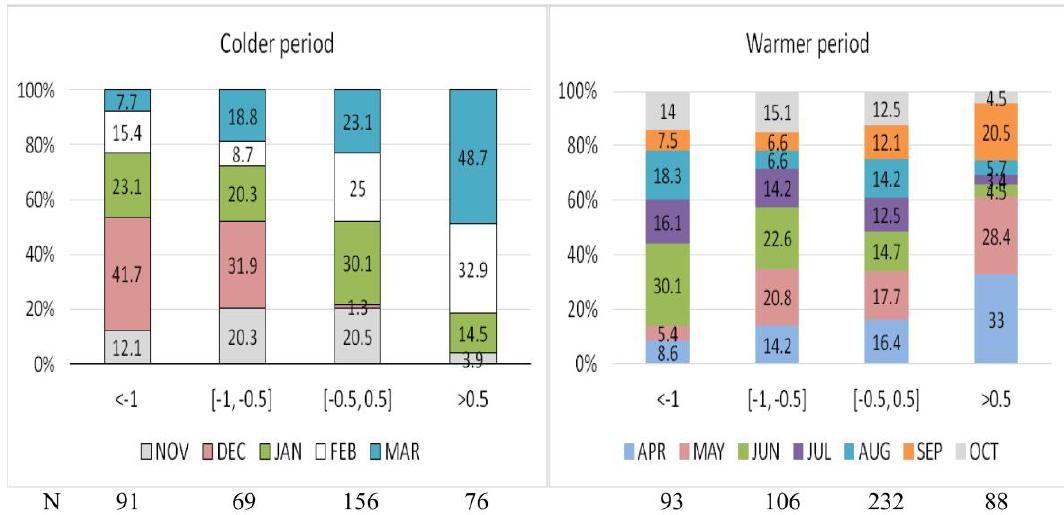
Figure 1. The monthly distribution in the categories of the NAO index during the colder period and the warmer period.